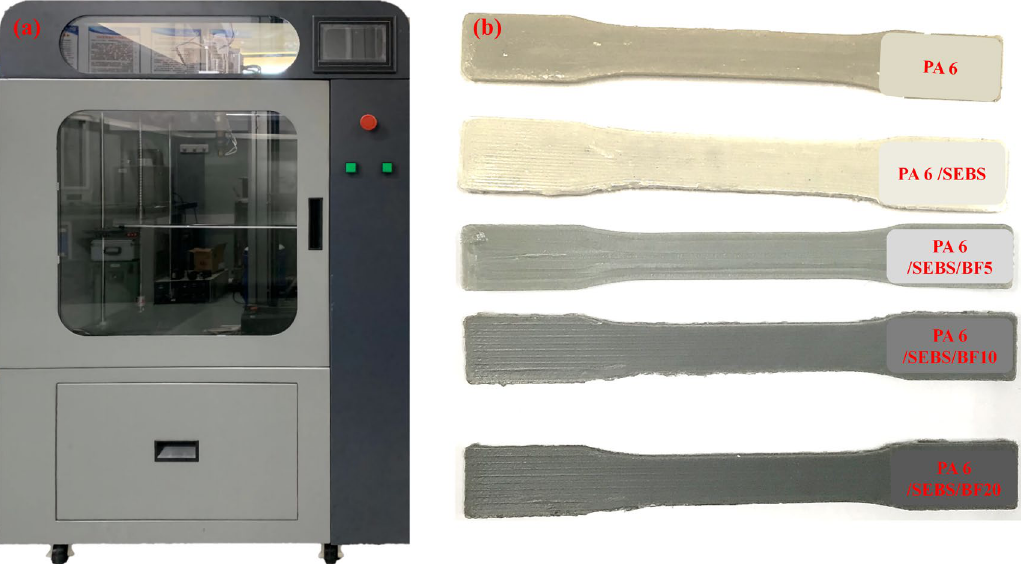
Figure 4. Electronic images of ( a ) self-developed extrusion-based 3D printer and ( b ) 3D-printed tensile specimens.